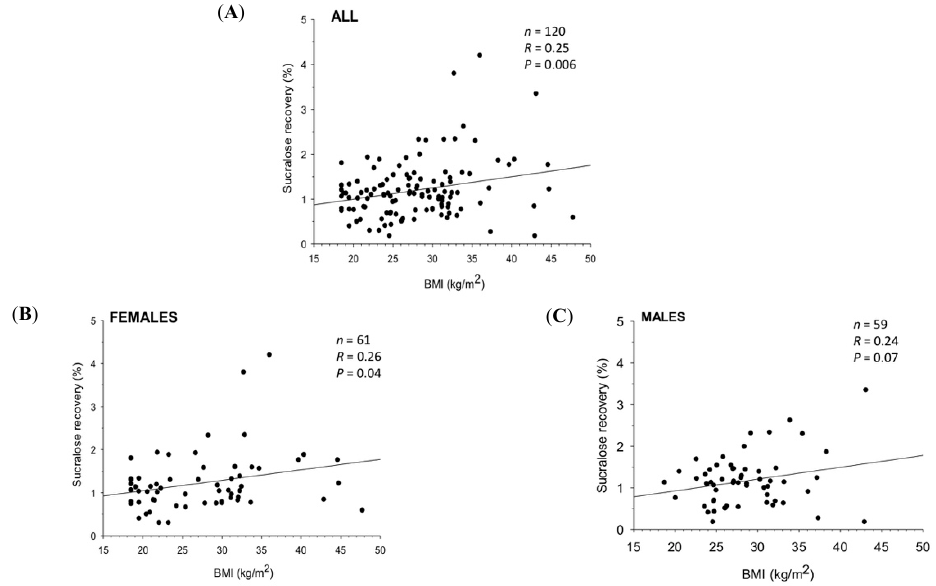
Figure 6. Colonic permeability (leakage) in a group of 120 subjects (61 females and 59 males; mean age 45 ± SEM1.2 years, range 18–75). Graphs show the correlation between urinary sucralose recovery (marker of colonic permeability) and body mass index (BMI) in: ( A ) all subjects; ( B ) females; ( C ) males. The prevalence of abnormal colonic permeability was higher in both overweight and obese than in normal weight subjects, and sucralose recovery increased significantly with BMI overall, in females ( p = 0.04), and tended to increase also in males ( p = 0.07). To measure overall intestinal permeability, four saccharide probes are administered orally and simultaneously. Stomach permeability is assessed by administering 20 g of sucrose; small intestine permeability is assessed by administering lactulose (5 g) and mannitol (1 g); and colonic permeability is assessed with 1 g of sucralose. A urinary sample